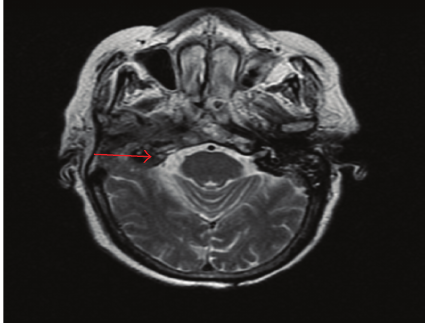
Figure 3: Showing well-di ff erentiated squamous cell carcinoma, characterized by sheets of cells with large cells with pleomorphic, hyperchromatic nuclei and individual cell keratinization, and keratin pearl